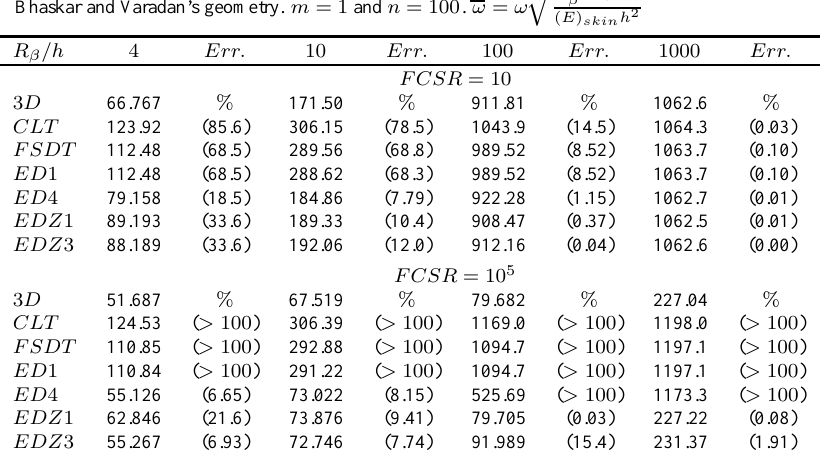
Table 7 Comparison of various theories to evaluate the fundamental frequency amplitude for the shell with Bhaskar and Varadan’s geometry. m = 1 and n = 100 . ω =